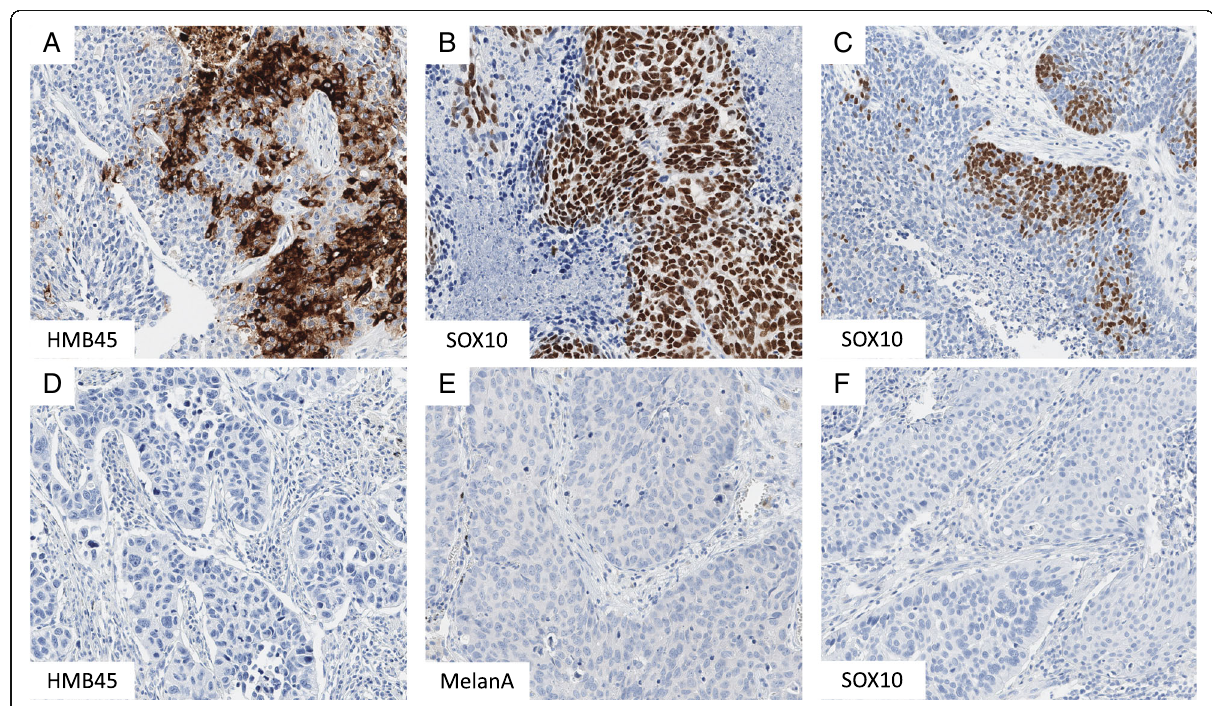
Fig. 1 Examples of immunohistochemical stainings. Positive ( a - c ) and negative ( d - f ) examples of HMB45 ( a , d ) and SOX10 ( b , c , f ) are displayed. A representative image of a negative MelanA stain ( e ) in SqCC is also demonstrated. SOX10 expression reached from strong expression in all tumor cells ( b ) to focal positivity in only a subset of cells ( c ). Mag.: 200×. HMB45, Human Melanoma Black 45, SqCC, squamous cell carcinoma, SOX10, SRY-related HMG-box 10